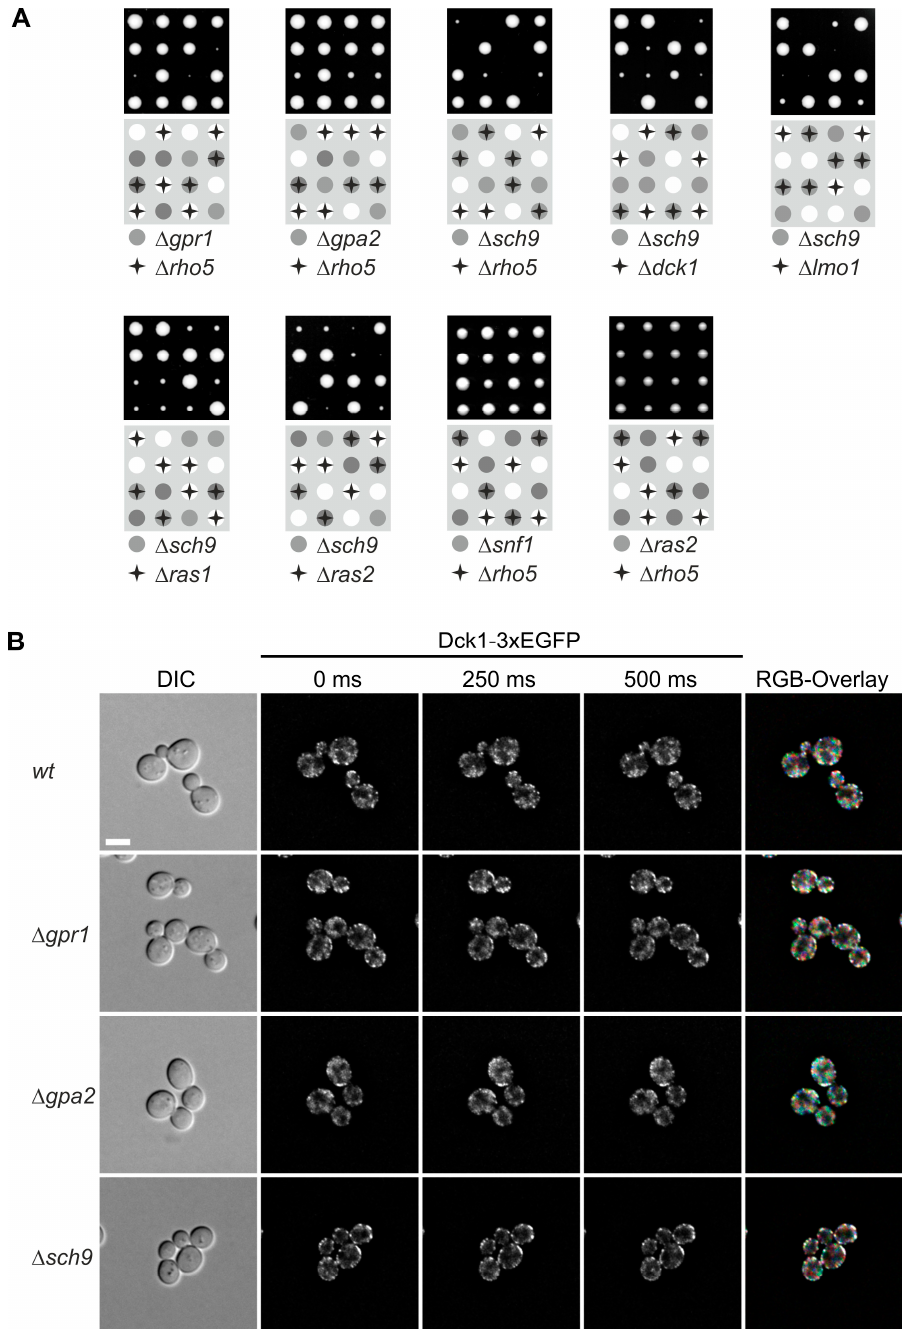
Figure 4. Deletions in genes encoding Rho5 or its dimeric GEF genetically interact with mutants in nutrient signaling, which is independent of foci formation. ( A ) Tetrad analyses reveal synthetic phenotypes between rho5 deletions and mutants defective in glucose signaling. Tetrad analyses of strains carrying the heterozygous deletions as indicated were performed. Four representative tetrads carrying all combinations as coded in the lower panels are shown in each case. ( B ) Fluorescence microscopy of Dck1-3×EGFP foci in different signaling mutants. Images were taken at different times and color coded as described in Figure 2. For ease of comparisons, the wild-type images from Figure 2 have been included, again. The size bar in the upper left image represents 5 µm and is valid for all images shown. See Materials and Methods for further details.